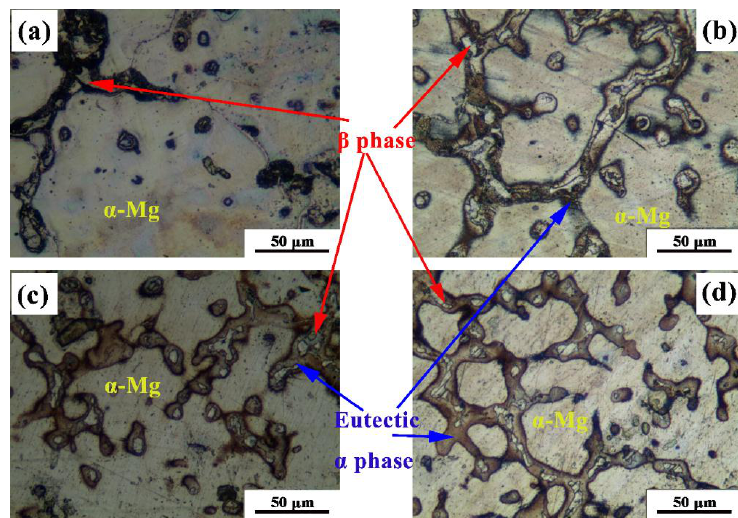
Figure 2. Optical morphologies of AZ63 ( a ), AZI1.0 ( b ), AZI1.5 ( c ) and AZI2.0 ( d ) alloys.